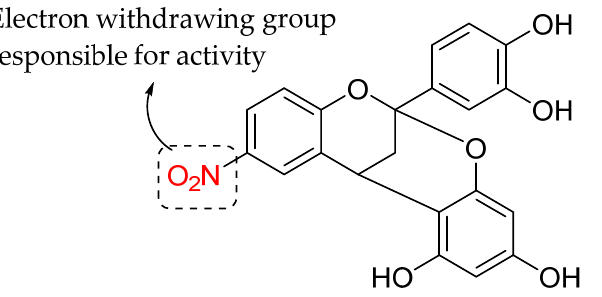
Figure 35. The chemical structure of 2-(3 ′ ,4 ′ -sDihydroxyphenyl)-6-nitrochromane-(4 → 4 ″ ,2 → O-5 ″ )-phloroglucinol [105].